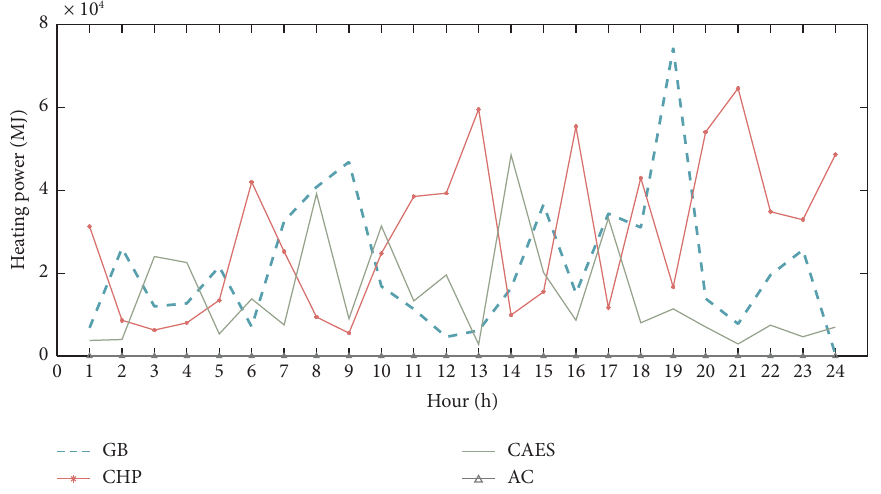
Figure 12: Heating energy dispatch in